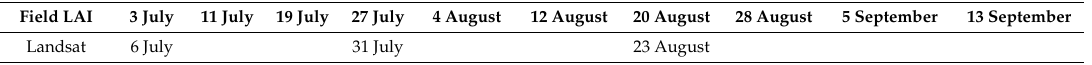
Table 1. Landsat data corresponding to field leaf area index (LAI) measurement dates.